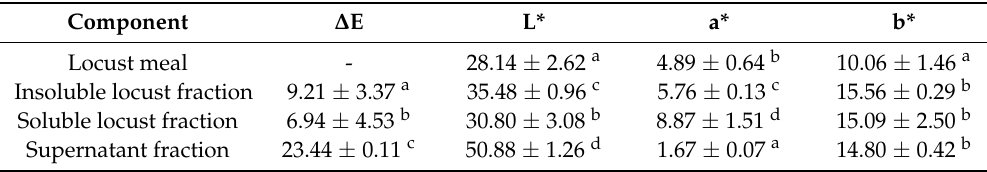
Table 4. Colour characteristics of whole and extracted locust protein